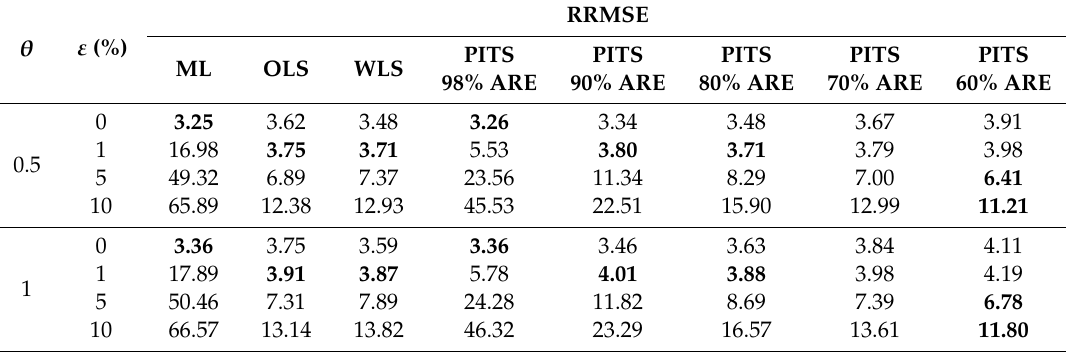
Table 8. RRMSE results for estimations of parameter θ with n = 500 and ε = 0%, 1%, 5%,